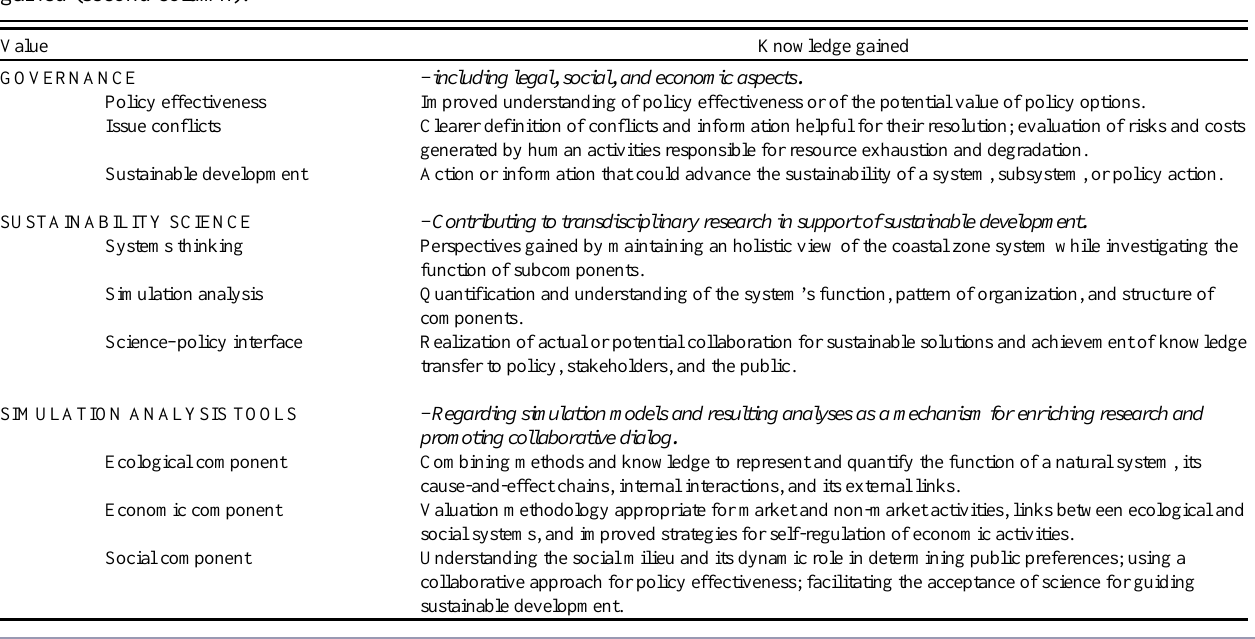
Table 1. Categories of values demonstrated by study-site applications (first column) and for each value a descriptor of knowledge gained (second